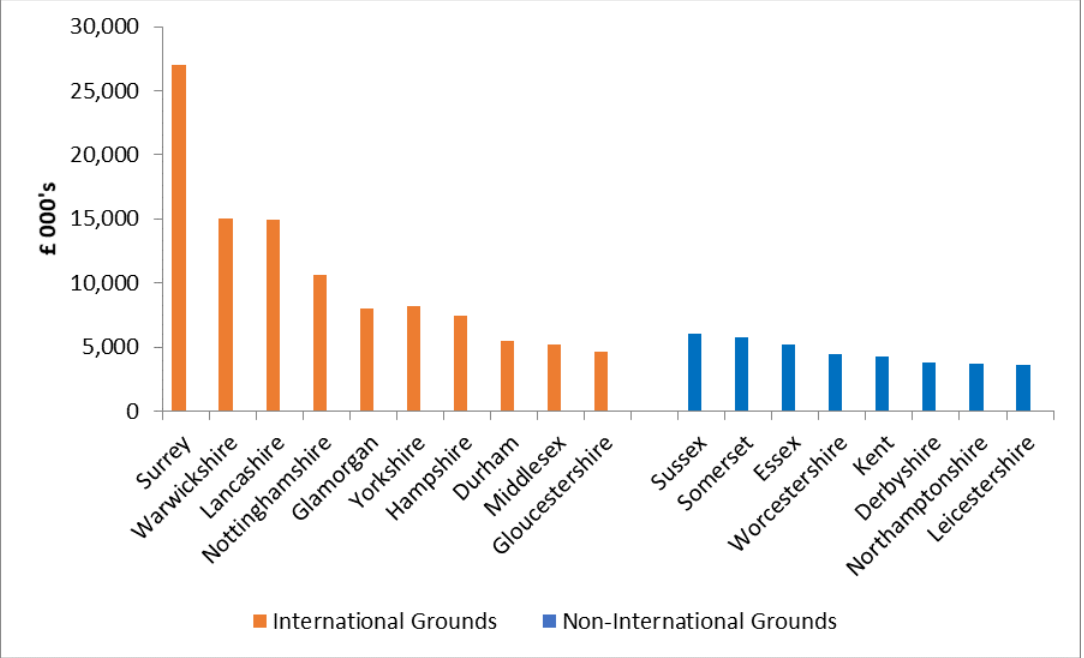
Figure 1. Average turnover in £000s (2014 – 2016).